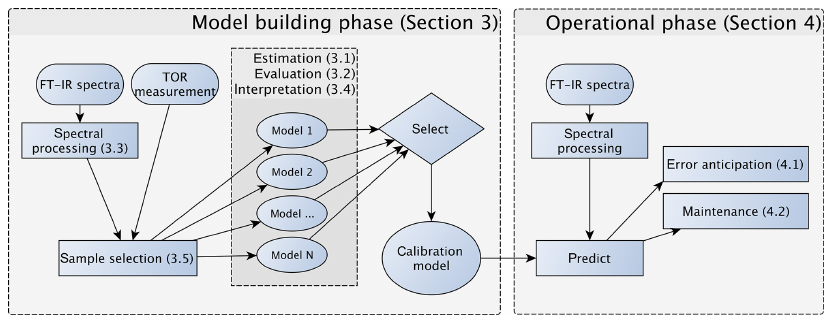
Figure 2. Diagram of the model building, evaluation, and monitoring process. Sections and subsections covering the illustrated topics are denoted in parentheses. Note that the any of the calibrations { 1 , 2 ,...,N } can be a multilevel model (Sect. 3.5.3) consisting of an ensemble of